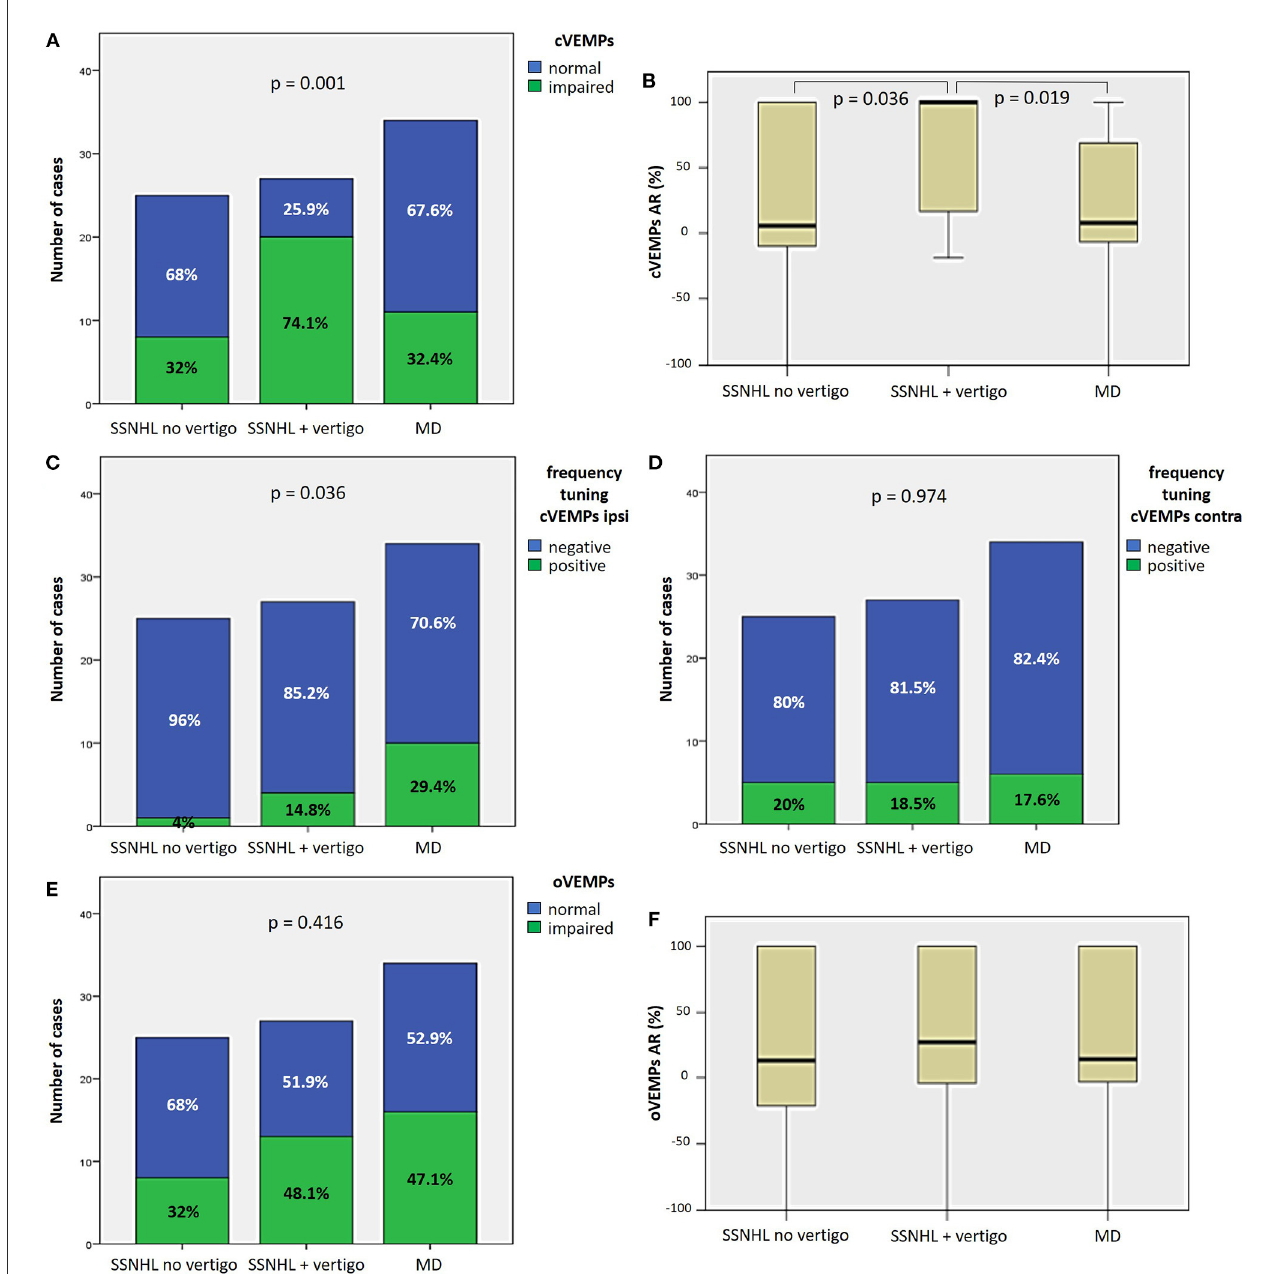
FIGURE3 Different distribution of saccular (A–D) and utricular dysfunction (E, F) , as assessed by c and oVEMPs, respectively, among different subgroups based on clinical course. (A) Bar plot showing the distribution of impaired saccular function of the side affected by SSNHL among different subgroups. Relative percentages are reported in each column and p -value of categorical comparisons is reported. (B) Box plot correlating median values of cVEMPs AR among subgroups. Statistically significant differences at the ANOVA test are shown. Bar plots showing the distribution of positive frequency tuning of cVEMPs of the side affected by SSNHL (C) and of the contralesional side (D) among different subgroups. Relative percentages are reported in each column and p -values of categorical comparisons are reported. (E) Bar plot showing the distribution of impaired utricular function of the side affected by SSNHL among different subgroups. Relative percentages are reported in each column and p -value of categorical comparisons is reported. (F) Box plot correlating median values of oVEMPs AR among subgroups. No statistically significant differences at the ANOVA test are shown. AR, asymmetry ratio; contra, contralesional ear; cVEMPS, cervical vestibular-evoked myogenic potentials; ipsi, affected ear; MD, Menière’s disease; oVEMPs, ocular vestibular-evoked myogenic potentials; SSNHL, sudden sensorineural hearing loss.